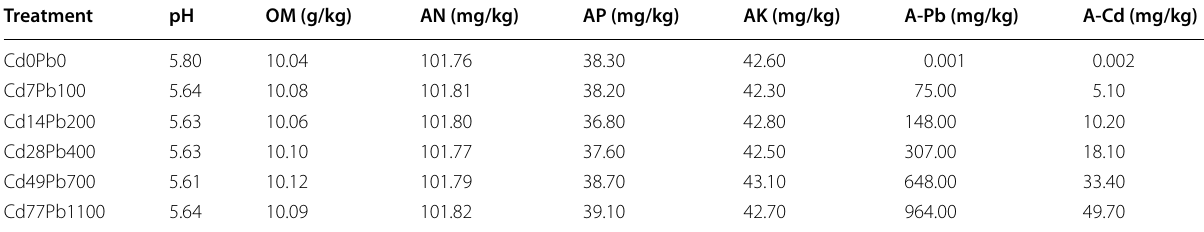
Cd0Pb0 denotes 0 mg/kg Cd and 0 mg/kg Pb. OM organic matter, AN available nitrogen, AP available phosphorus, AK available potassium, A-Pb available lead, A-Cd available cadmium